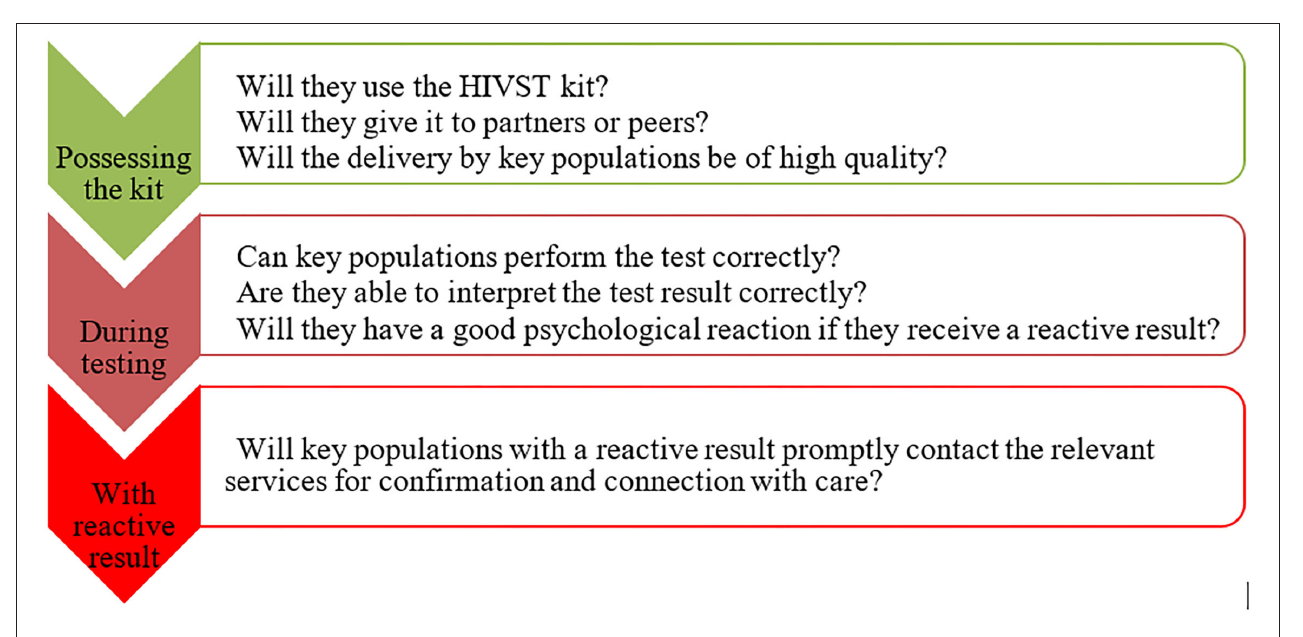
FIGURE 1 | Participants’ main question concerning the use of HIVST by key